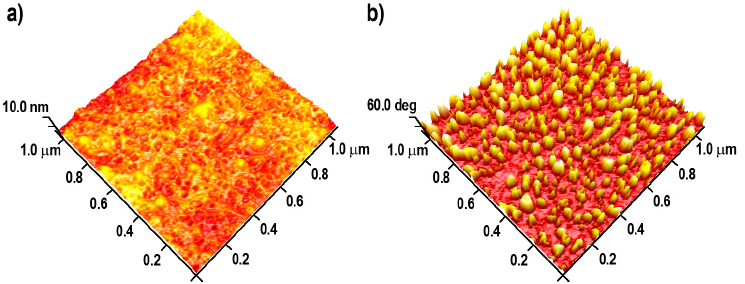
Figure 6. Height ( a ) and phase contrast ( b ) tapping-mode atomic force microscopy (TM-AFM) micrographs of an iPS- b -iP(E- alt -S) block copolymer with 23 wt % of iPS in the polymer backbone. Reproduced from [41] with permission from The Royal Society of Chemistry.